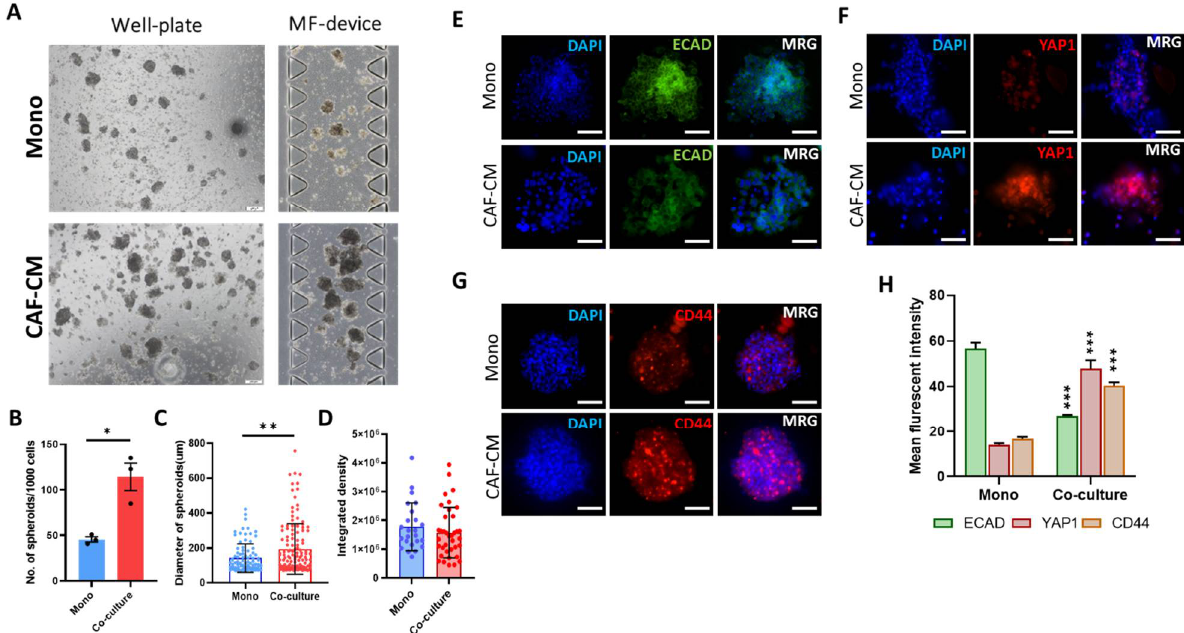
Figure 3. CAFs induces spheroid formation with increased diameter and expression of YAP1. ( A ) Bright-filed snapshot image of the formation of spheroids in well-plate (left) and microfluidic device (right) co-cultured with or without CAF-CM. The micrographs show an increase in the number and size of generated spheroids on both platforms in the presence of CAF-CM. (Scale bar: 200 µm) ( B ) The CAF-CM significantly increased the formation of spheroids per 1000 cells in comparison with monoculture. ( C ) In comparison with monoculture, co-culturing cancer cells with CAF-CM significantly increased the size of generated spheroids. ( D ) The integrated density in spheroids co-cultured with CAF-CM was lower than in monoculture, indicating the stimulation of cell invasion from spheroids in the ECM channel. ( E – G ) The immunofluorescence staining of the EMT marker ECAD ( E ) and stemness marker CD44 ( F ) indicates that CAF-CM stimulates EMT and stemness. Co-culturing with CAF-CM increased the expression of YAP1 in generated spheroids (Scale bar: 100 µm). ( H ) The quantitative analysis of mean fluorescence intensity in ECAD, YAP1, and CD44 resulted in a significant reduction in the expression of ECAD and an increase in CD44 and YAP1 in the co-culture group to the monoculture. * p < 0.05, ** p < 0.002, *** p < 0.0002 using the Student t -test.